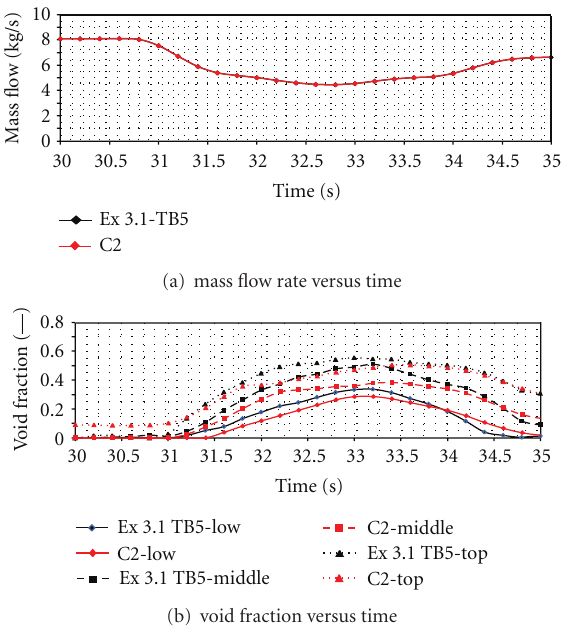
Figure 9: PSBT transient bundle tests (TS 5)—flow reduction— CATHARE2 3D: calc. versus exp., reference results